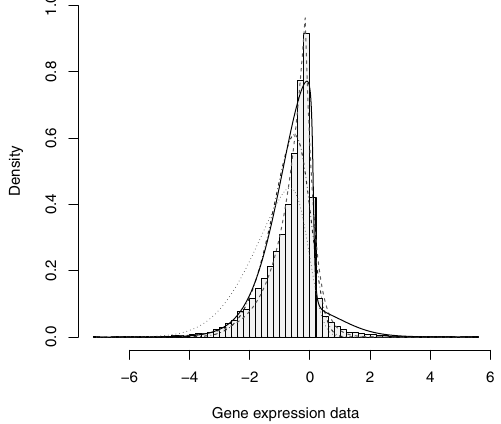
Figure 4 – Fitted asymmetric slash Laplace (ASL) probability density function (red dashed line (the peaked one)) to the microarray gene expression data along with skew slash t (black line), skew slash (blue dash and dot line) and skew normal (dotted